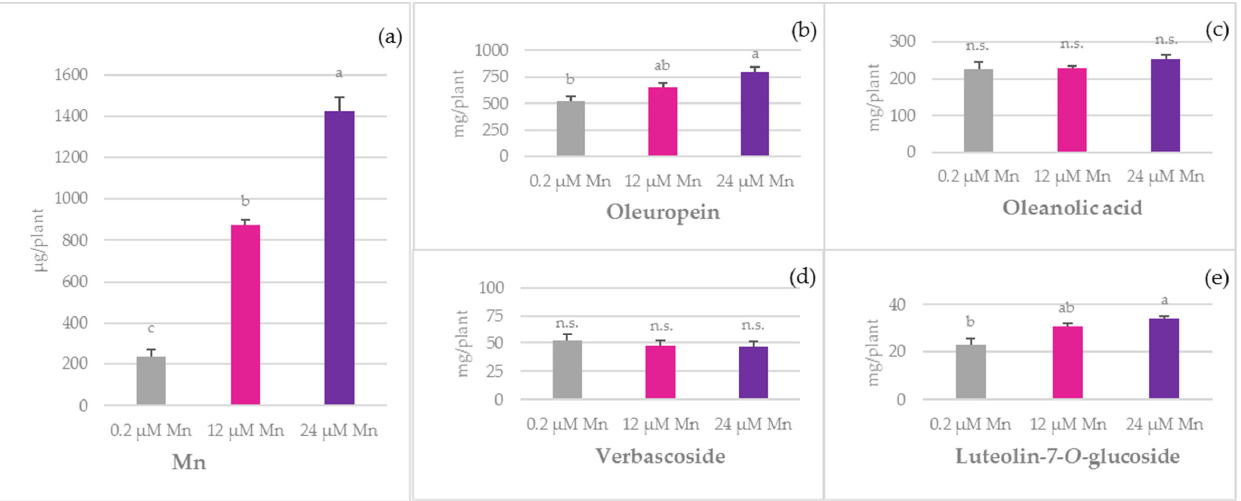
Figure 4. The effect of manganese (Mn) application on the total per plant quantity of ( a ) Mn, ( b ) oleuropein, ( c ) oleanolic acid, ( d ) verbascoside, and ( e ) luteolin-7- O -glucoside of ‘Istarska bjelica’ olive cv. (mean values ± SE, n = 4). Mean values followed by different letters are significantly different at p < 0.05 according to Tukey’s test. Table 2. Correlation coefficients between the total per plant quantity of Mn and simple biophenols, phenolic acids, and flavonoids of ‘Istarska bjelica’ olive cv. treated with three different manganese (Mn) concentrations.